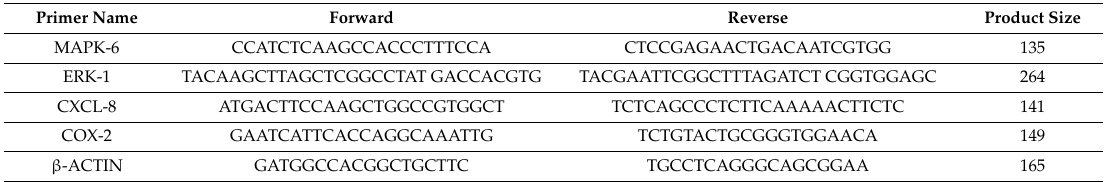
Table 1. Details of the sequences of real-time PCR primers.